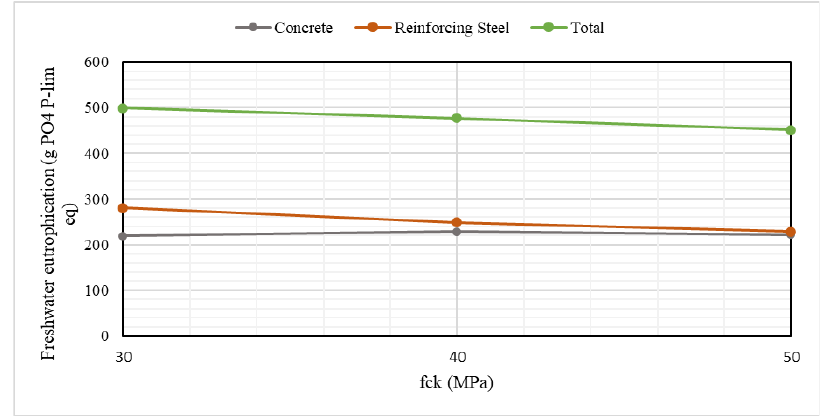
Figure 9. Freshwater eutrophication impacts for RC columns